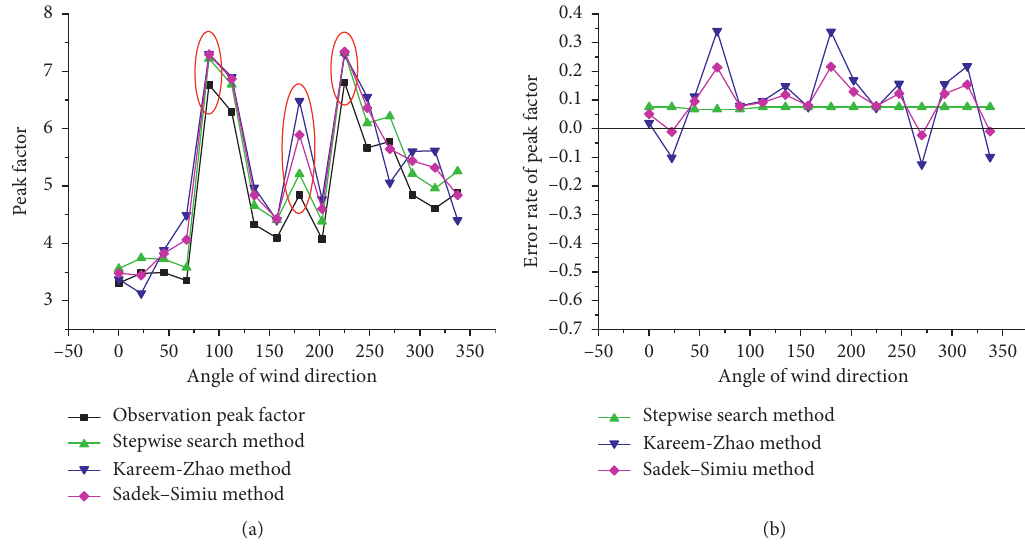
Figure 9: (a) Variation of peak factor with wind direction angle and (b) variation of error rate with wind direction angle of measurement point 5-17. Table 2: Non-Gaussian judgement of measurement point 5-17 under different wind direction angles. Measurement point Angle Skewness Kurtosis Judgment value of non-Gaussian